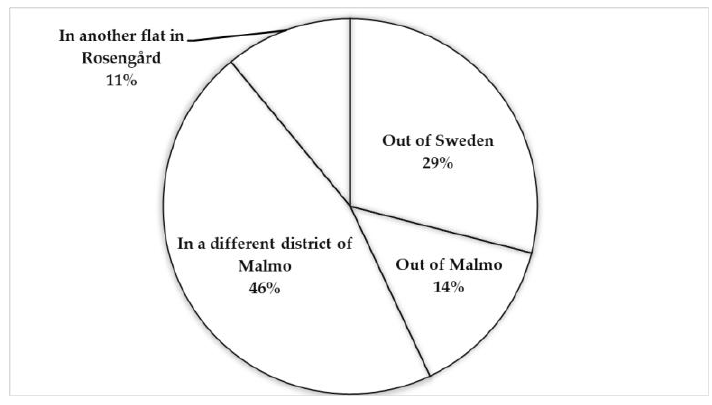
Figure 7. Previous place of living before moving in Rosengård, survey, 2019.